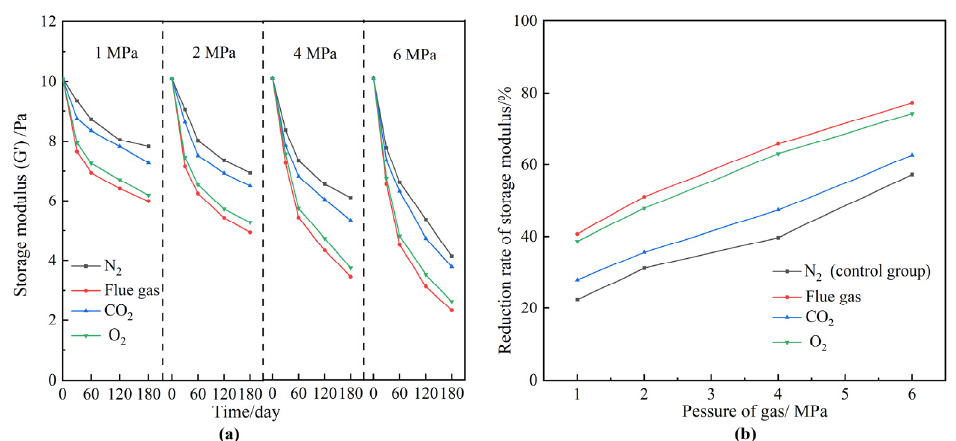
Figure 4. The effect of gas species and gas pressures on gel long-term stability. ( a ) G ′ of gels at elevated gas pressures versus aging time; ( b ) reduction rate of gel strength after aging for 180 days.